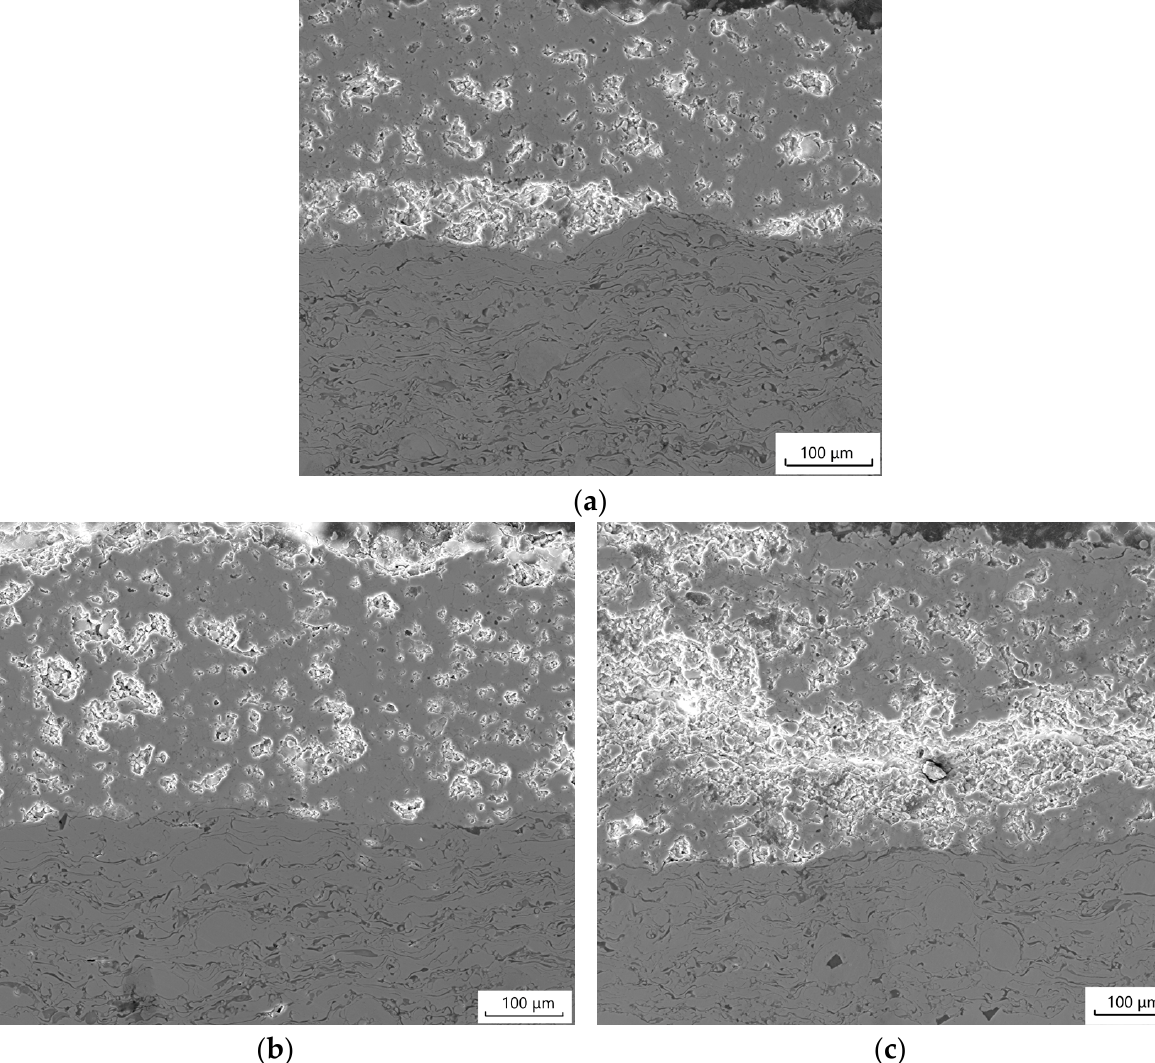
Figure 6. Microstructure of the deposited layer porous TBCs: ( a ) 0%; ( b ) 10%; ( c ) 15%.